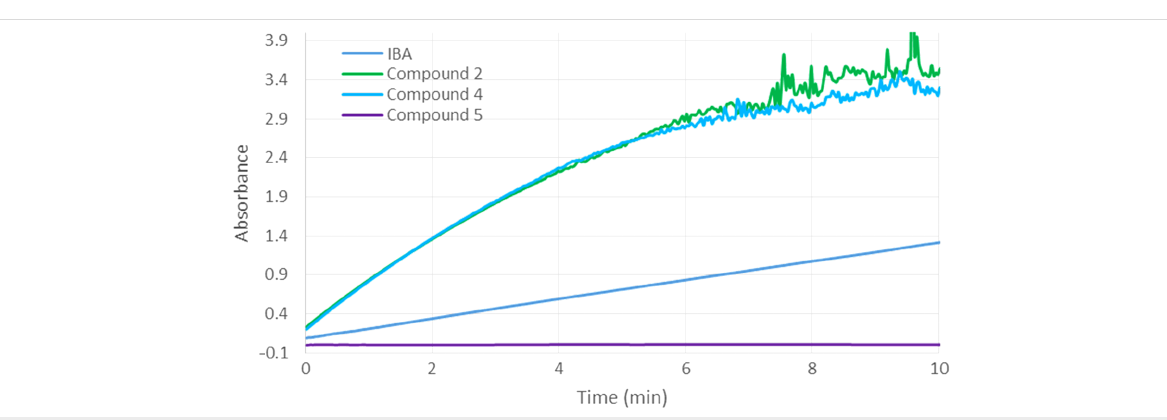
Figure 7: Hydrolysis of methyl paraoxon (0.5 mM) in the presence of compounds 2 , 4 , 5 or 2-iodosobenzoic acid (IBA) at 0.5 mM concentration.